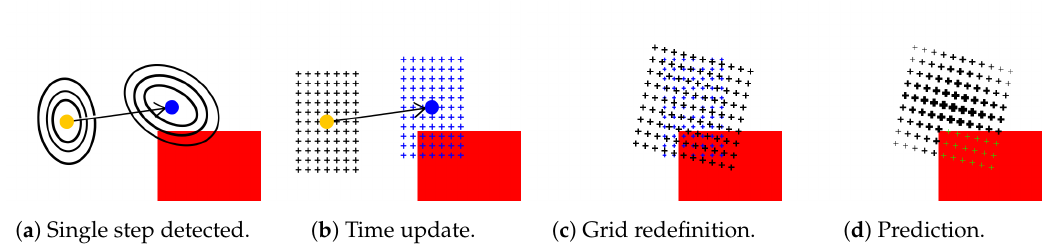
Figure 4. A step is performed from the yellow to the blue point. Circles denotes true pdf ( a ) which is approximated by a grid. Grid H k + 1 (blue points) is obtained from the original grid G k ( b ), which is later ( c ) redefined to the grid G k + 1 (black points). The convolution sets belief values ( d ) in respect to the prior grid and the measurements (red area represents a wall; a larger point width denotes a larger belief